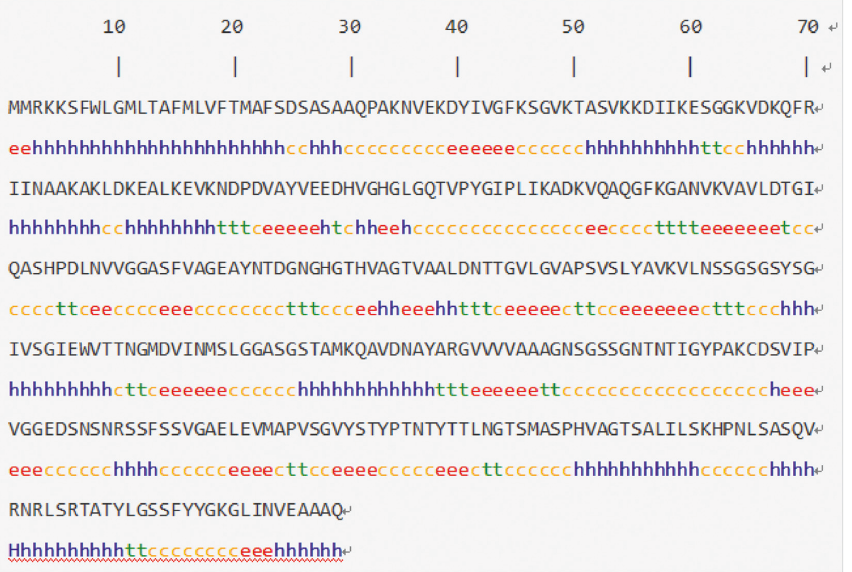
Figure 4: Secondary structure prediction of Bacillus subtilis by the SOPMA server (h: alpha-helix; e: beta-strand; t: beta-turn; c: random coil).